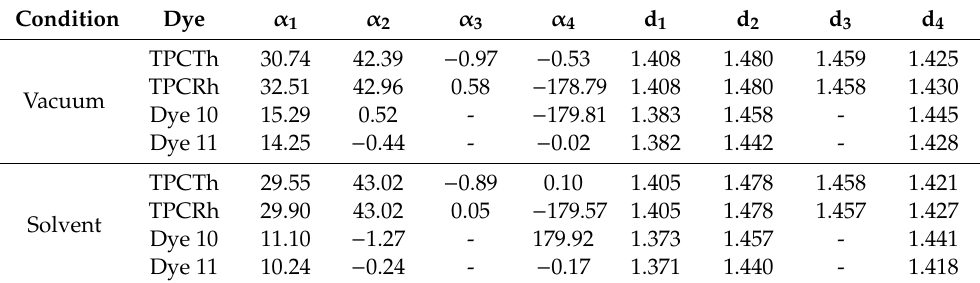
Table 1. Specific bond length (Å) and dihedral angle ( ◦ ) in vacuum and CH 2 Cl 2